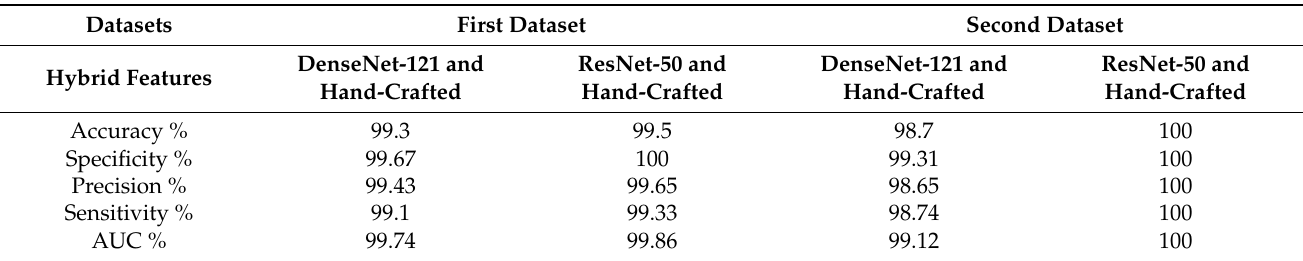
Table 4. FFNN classifier performance results with the hybrid features of the two datasets of malig- nant